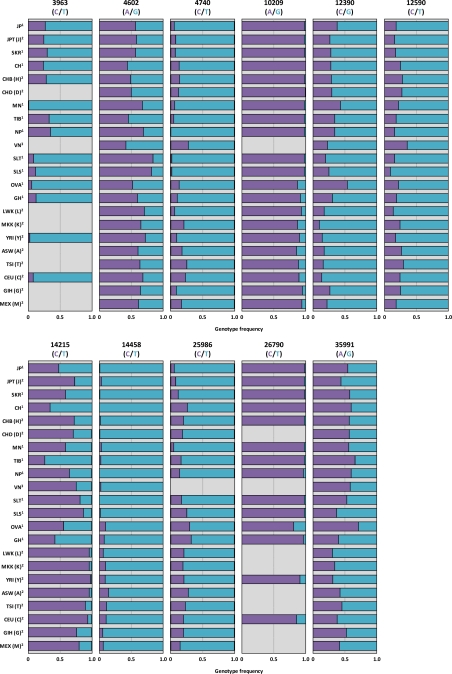
Frequencies of alleles in AS3MT in various populations reported in our studies [20,65] and the HapMap Project [31]. JP: Japanese, JPT (J): Japanese in Tokyo, Japan, SKR: South Koreans, CH: Chinese, CHB (H): Han Chinese in Beijing, China, CHD (D): Chinese in Metropolitan Denver, Colorado, MN: Mongolians, TIB: Tibetans, NP: Nepalese, VN: Vietnamese, SLT: Sri Lanka-Tamils, SLS: Sri Lanka-Sinhalese, OVA: Ovambos, GH: Ghanaians, LWK (L): Luhya in Webuye, Kenya, MKK (K): Maasai in Kinyawa, Kenya, YRI (Y): Yoruban in Ibadan, Nigeria, ASW (A): African ancestry in Southwest USA, TSI (T): Tuscan in Italy, CEU (C): Utah residents with Northern and Western European ancestry from the CEPH collection, GIH (G): Gujarati Indians in Houston, Texas, MEX (M): Mexican ancestry in Los Angeles, California. 1; Fujihara et al. [65], 2; Agusa et al. [20], 3; HapMap Project [31].